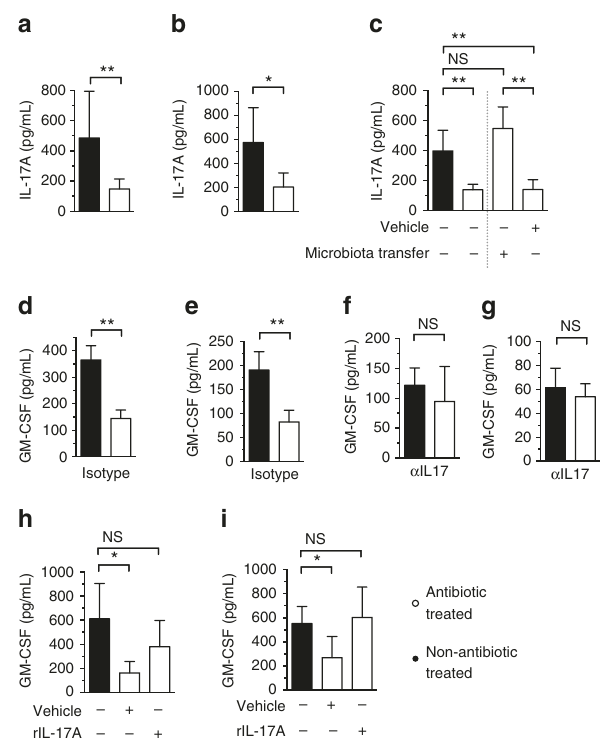
Fig. 2 The microbiota primes GM-CSF production during infection through IL-17A. a – c IL-17A levels in lung tissue 12 h post-inoculation with K . pneumoniae ( a ) and S . pneumoniae ( b , c ). For microbiota transfer, mice were intranasally inoculated with 10 μ L of upper respiratory tract lavage fl uid and orally inoculated with 200 μ L of fecal suspension 72 h prior to S . pneumoniae infection. d – g GM-CSF levels in lung tissue 12 h post- inoculation with K . pneumoniae ( d , f ) and S . pneumoniae ( e , g ). Indicated groups were intranasally administered an IL-17A-neutralizing antibody (100 μ g/mouse via intraperitoneal injection), or isotype control 72 h prior to, and concomitant with, intranasal infection. h , i GM-CSF levels in lung tissue 12 h post-inoculation with K . pneumoniae ( h ) and S . pneumoniae ( i ). Indicated groups of mice were treated intranasally with rIL-17A, or vehicle control (5 μ g/mouse) concomitant with bacterial challenge. Data ( a – i ) are from n = 5 – 6 mice/group and error bars are s.d. Statistical comparisons were by Mann – Whitney ( a , b , d – g ), or by one-way ANOVA with post-hoc Sidak ’ s or Dunnett ’ s test ( c , h and j ), * P < 0.05, ** P < 0.01, *** P <